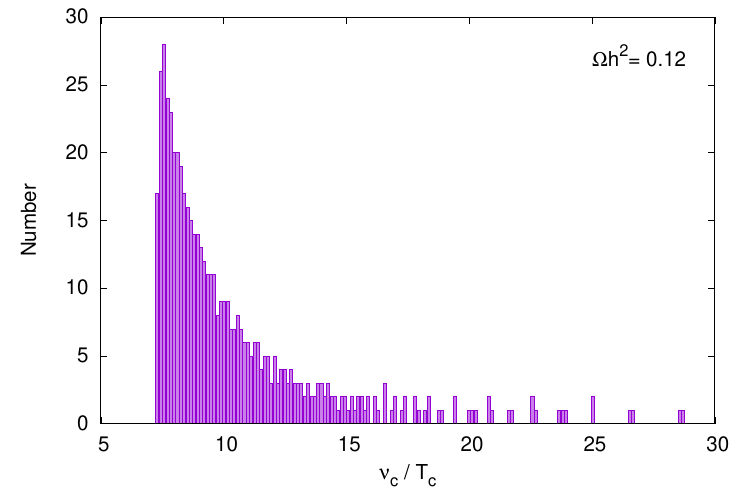
Figure 7 . The frequency distribution of the order parameter (cid:23) c =T c for the samples which are satisfying DM relic density constraint. This (cid:12)gure shows that (cid:23) c =T c > 7, implying a strongly (cid:12)rst order phase